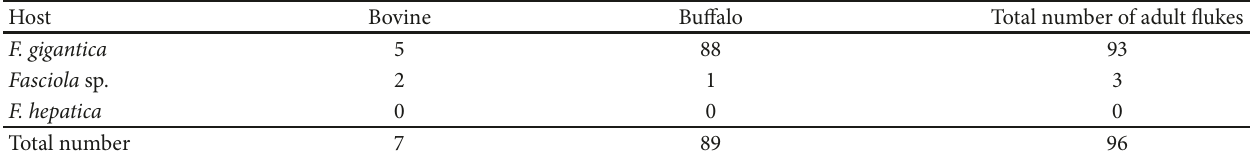
Table 1: Frequency of F. gigantica and F. hepatica identified by PCR-RFLP in different animal hosts in Vietnam.